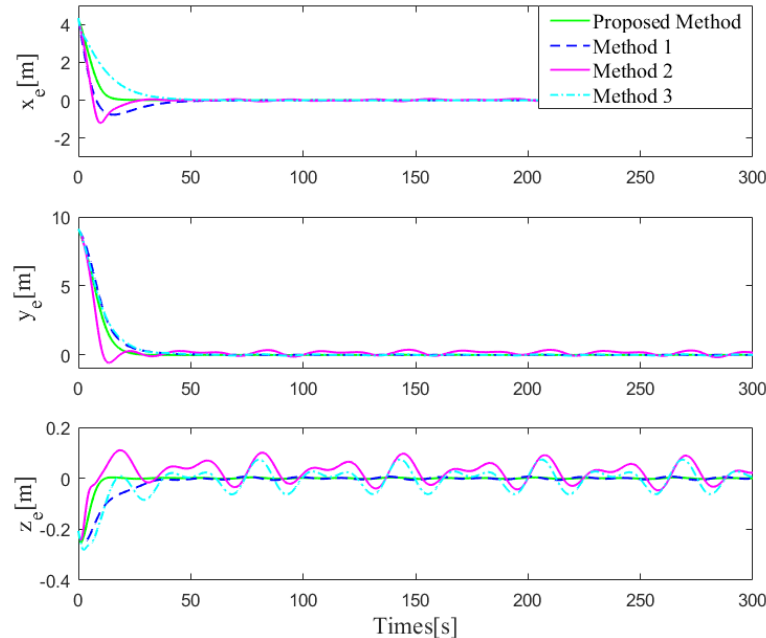
Figure 11. The tracking error comparison.